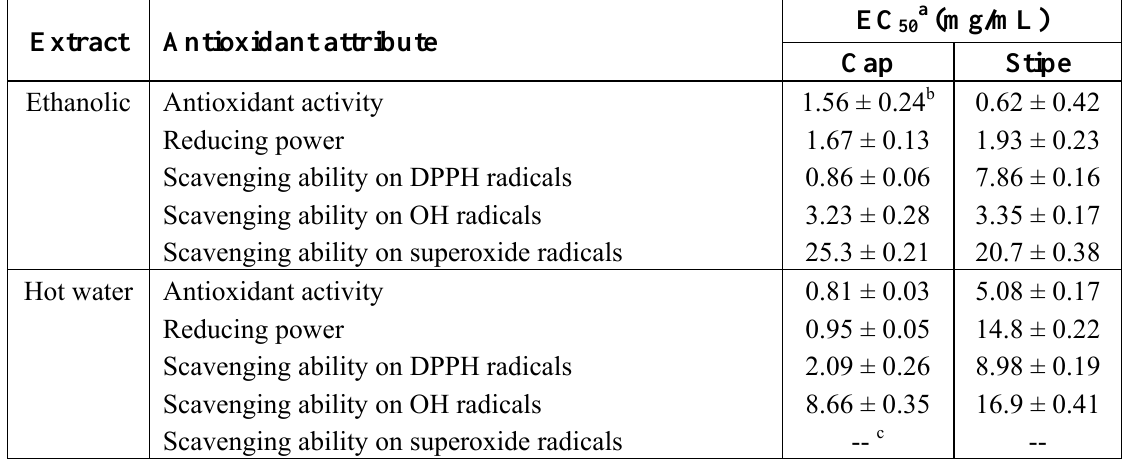
Table 2. EC values of ethanolic and hot water extracts from cap and stipe of Coprinus 50 comatus in antioxidant properties.